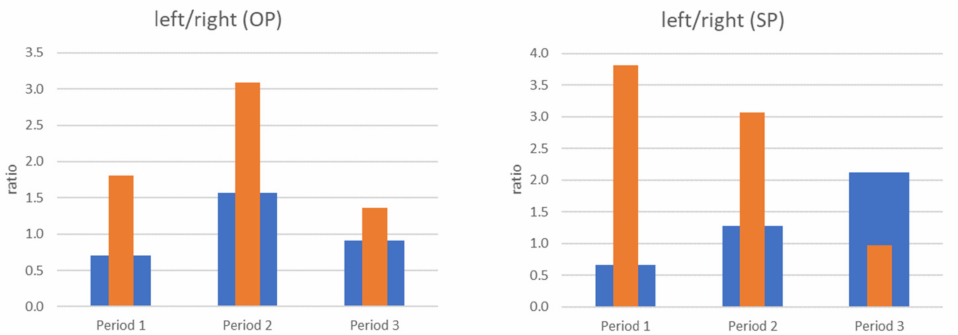
Figure 13. Acceleration (blue bar) and EMG signals (orange bar) ratio for OP (opening with protrud- ing) and SP (slow